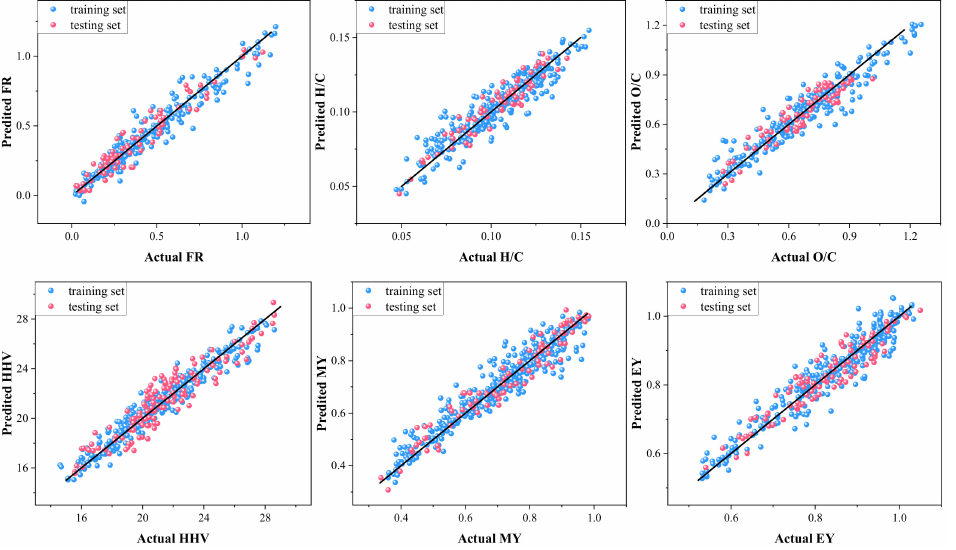
Figure 5. Comparison of GA-BPNN predicted values and experimental data.